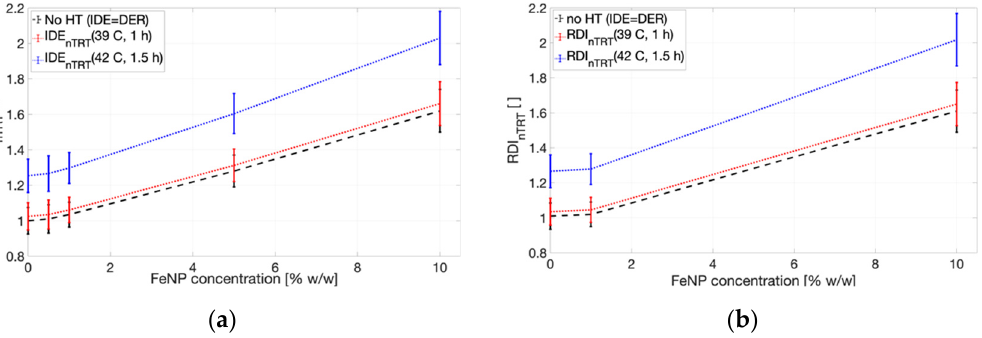
Figure 8. Nano ‐ thermo ‐ radiotherapy integral dose enhancement ( IDE nTRT ) at the glioblastoma PTV as a function of the different FeNP concentrations for a 1.5 T magnetic field perpendicular ( a ) and parallel ( b ) to the incident X ‐ ray beam.